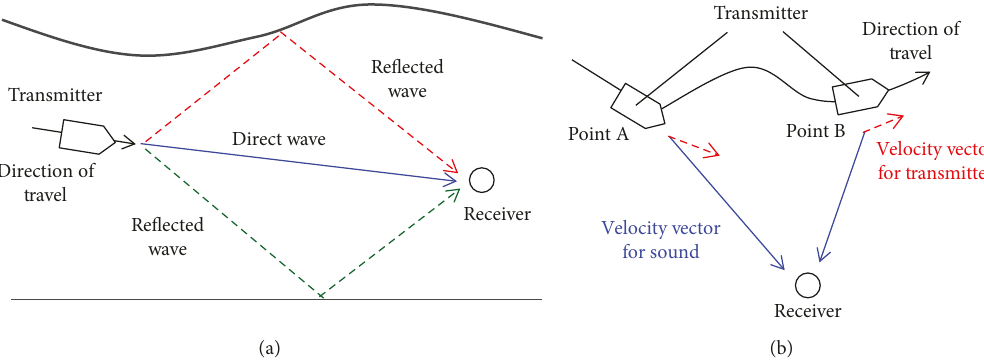
Figure 1: Types of nonuniform Doppler shifts. (a) Doppler spread and (b) Doppler